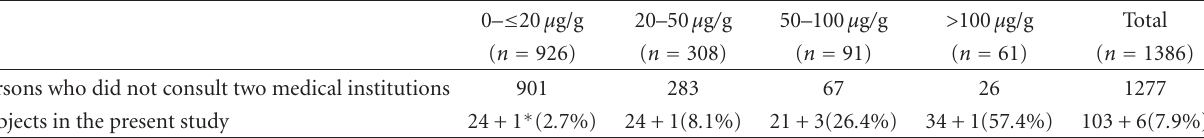
Table 1: Distribution of the 103 subjects among 1,386 persons (whose hair mercury concentrations were measured) separated by the exposure category.